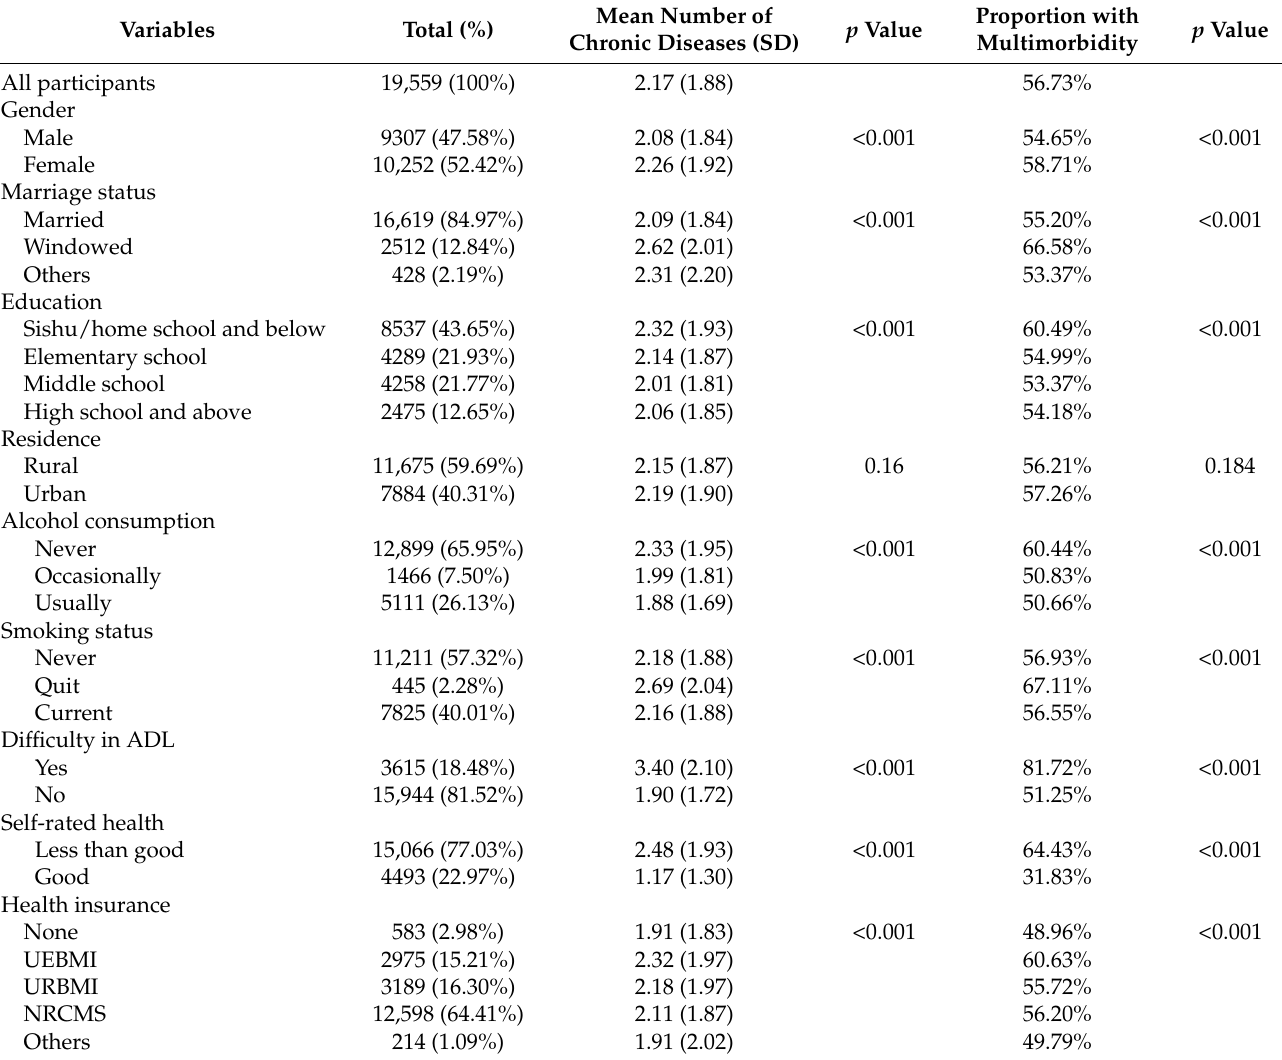
Table 1. Characteristics of the sample ( n =